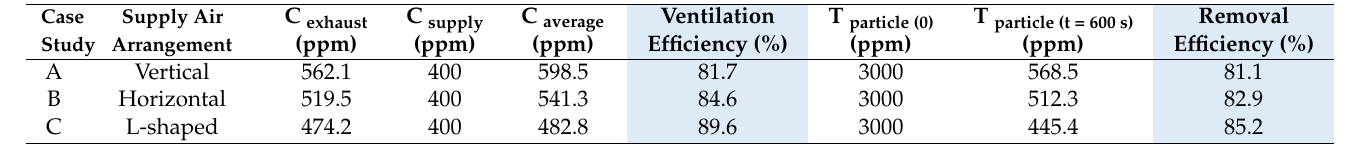
Table 5. Ventilation and removal efficiency in different ventilation